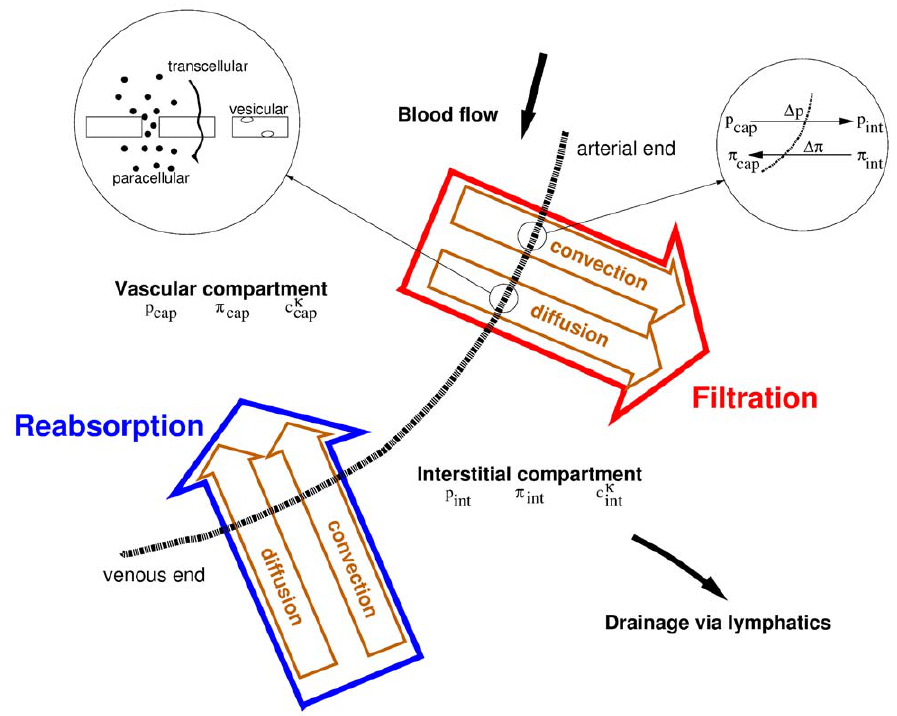
Figure 8. Processes and forces of transvascular exchange [ 48 ] .